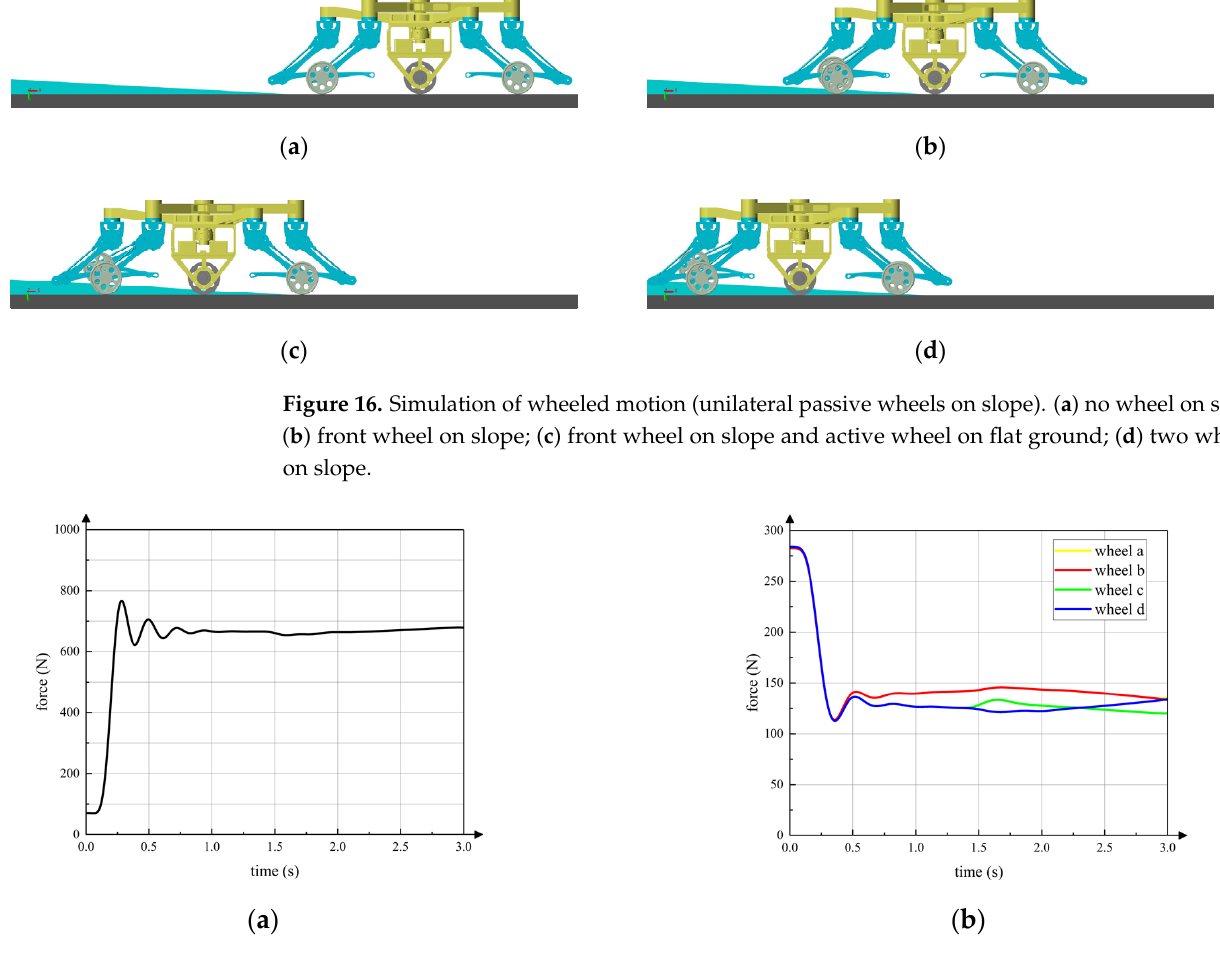
Figure 17. Vertical contact force between wheels and ground (unilateral passive wheels on slope). ( a ) active wheel; ( b ) passive wheels.